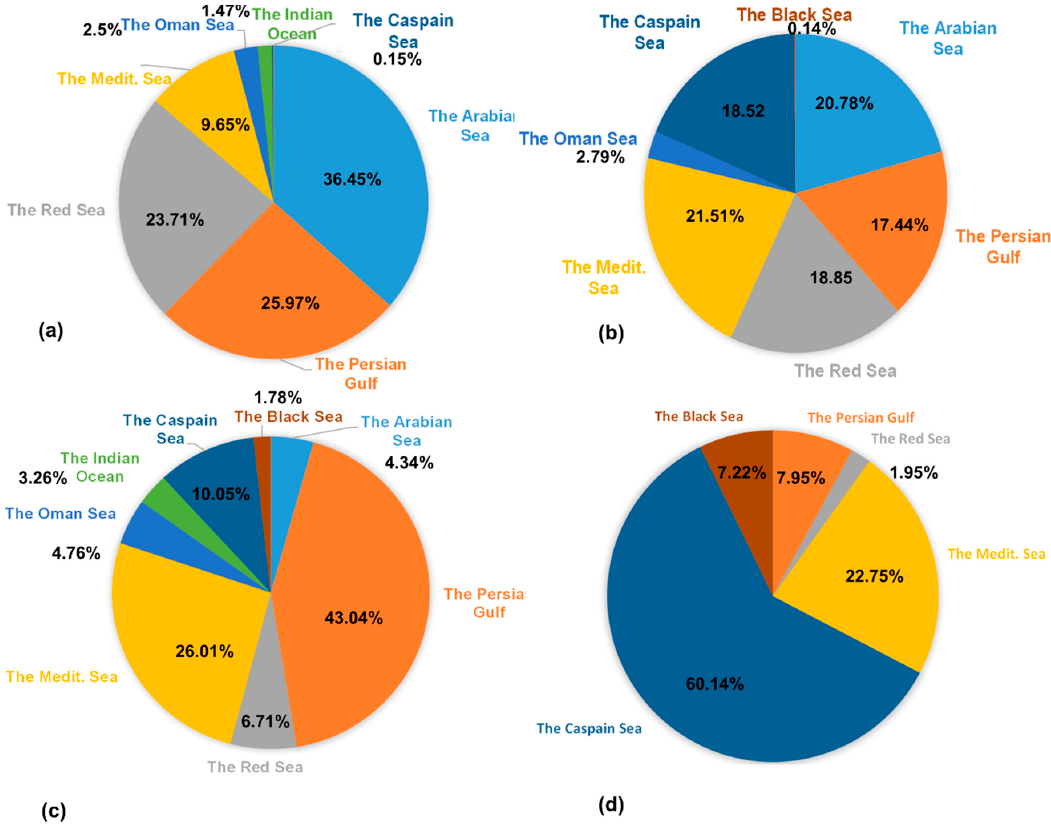
Figure 8. The moisture uptake ratios from various oceanic sources for the Shiraz ( a , c ) and Mashhad ( b , d ) locations during the wet and dry seasons, respectively.